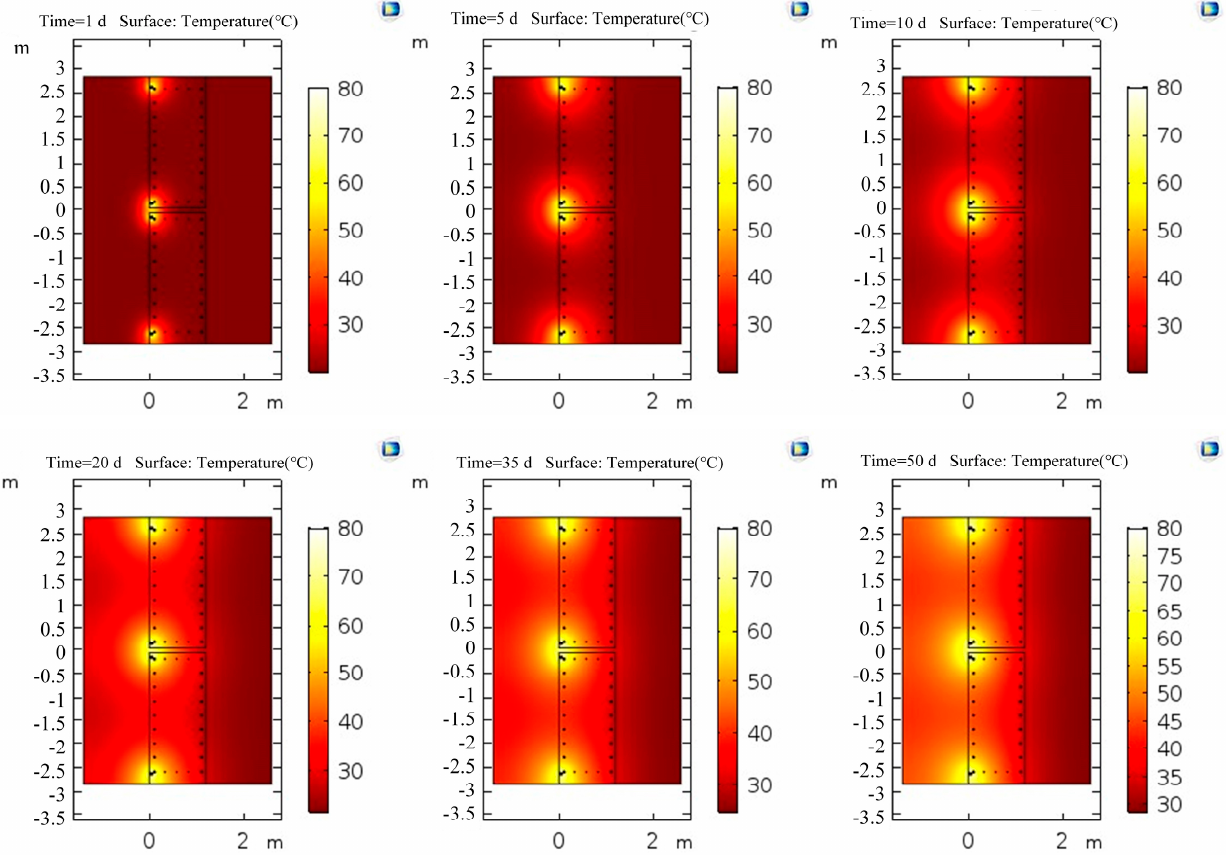
Figure 22. Distribution of temperature field in a model without tension reinforcement. The distribution of the temperature field for 1, 5, 10, 20, 35, and 50 days of